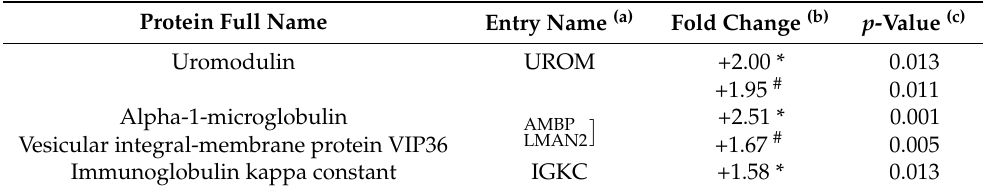
Table 1. Differentially expressed proteins detected by SDS-PAGE and identified by LC-MS/MS